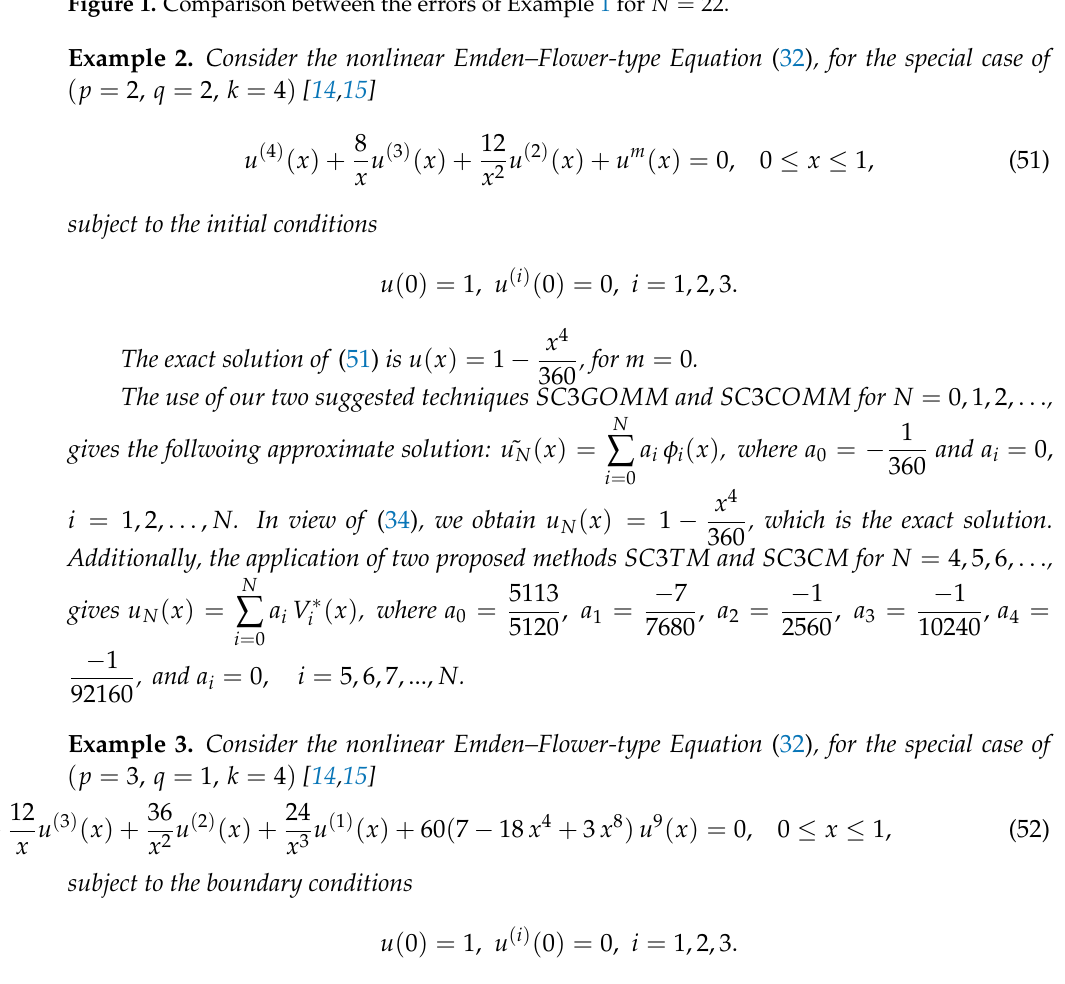
Figure 1. Comparison between the errors of Example 1 for N =